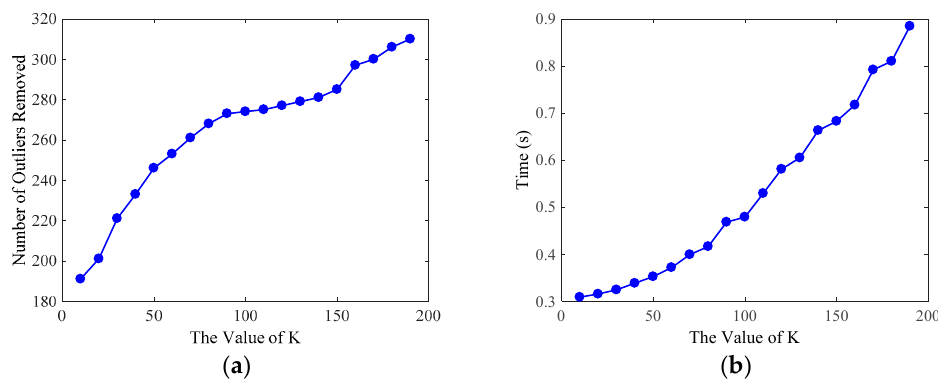
Figure 8. Evaluation results of the statistical outlier removal method. We set the number K of each point’s nearest neighbors as the abscissa, and the evaluation was conducted on 20 point clouds using a sequence of different K values. ( a ) The number of outliers removed by statistical outlier removal method with respect to different K values. ( b ) The runtime of the method. Both the number of outliers removed and runtime increase with an increase of K value.